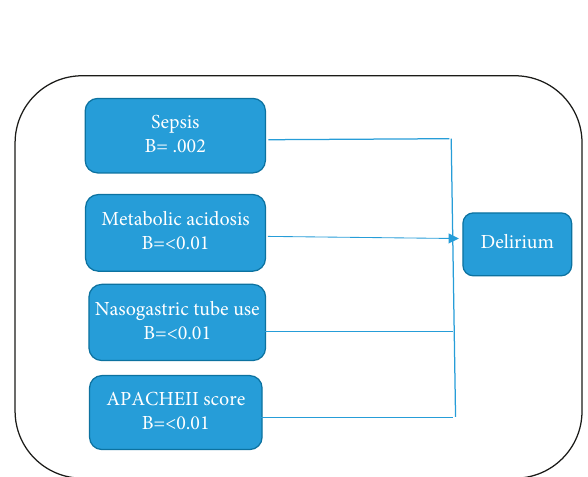
Figure 1: Model of predictors of overall patient safety